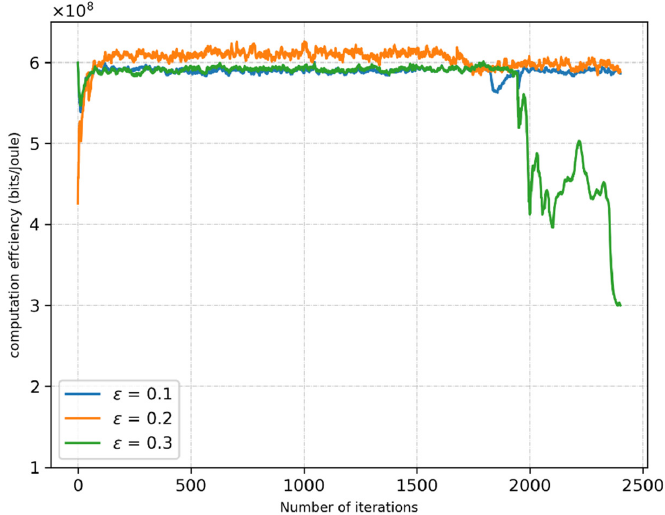
Figure 5. Convergence performance with different clipping function factors.